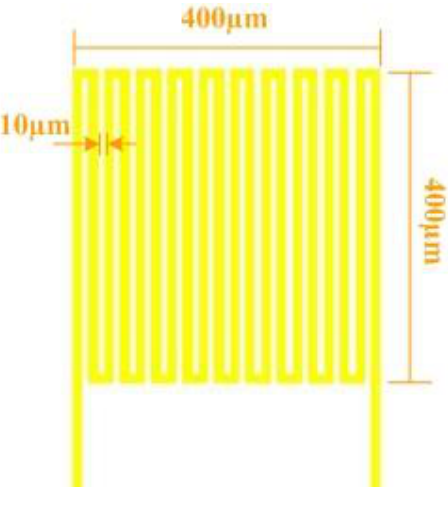
Figure 1. Design of a micro temperature sensor.